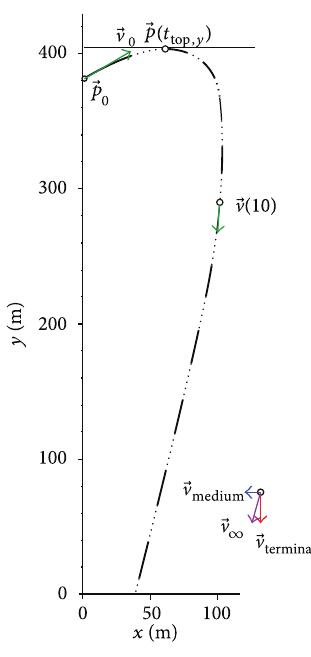
Figure 5: The velocity and 𝑦 -top of a